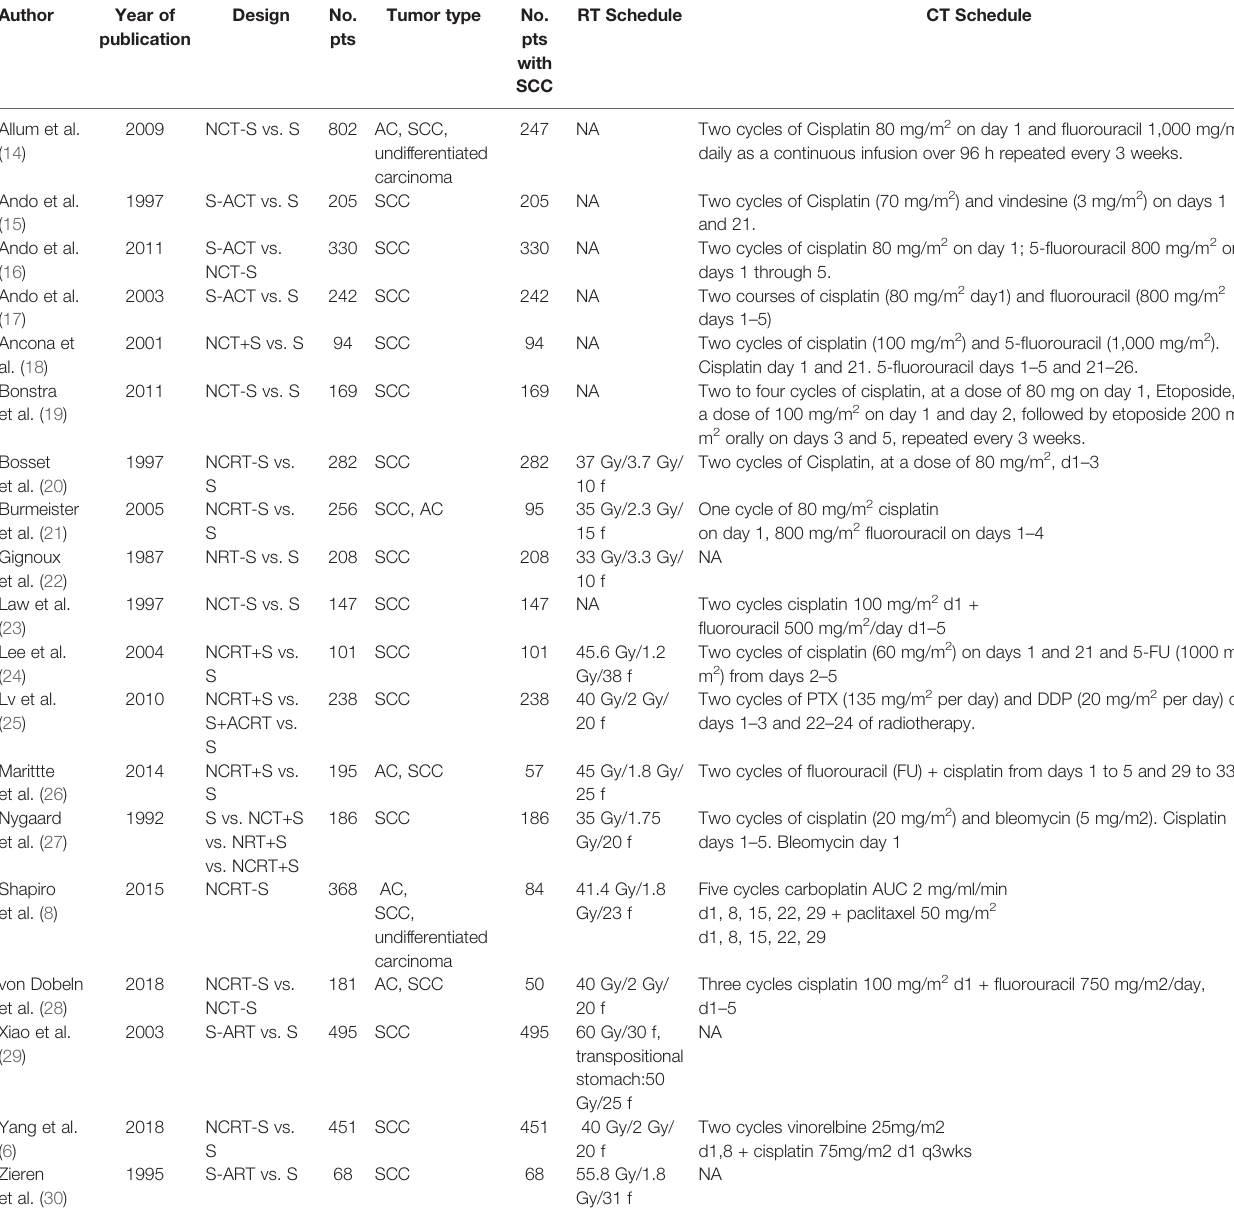
TABLE 1 | Essential characteristics of the studies included in the meta-analysis.